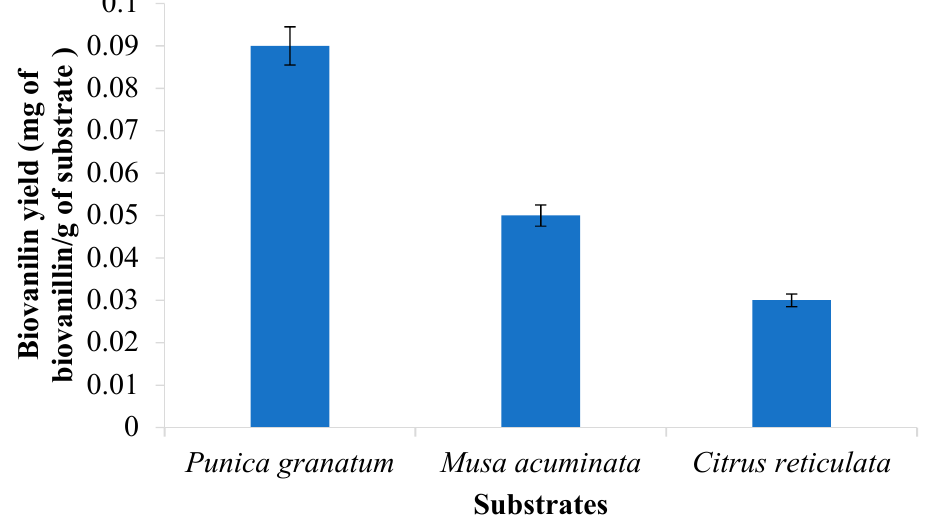
Figure 1. Screening of substrates for biovanillin production.